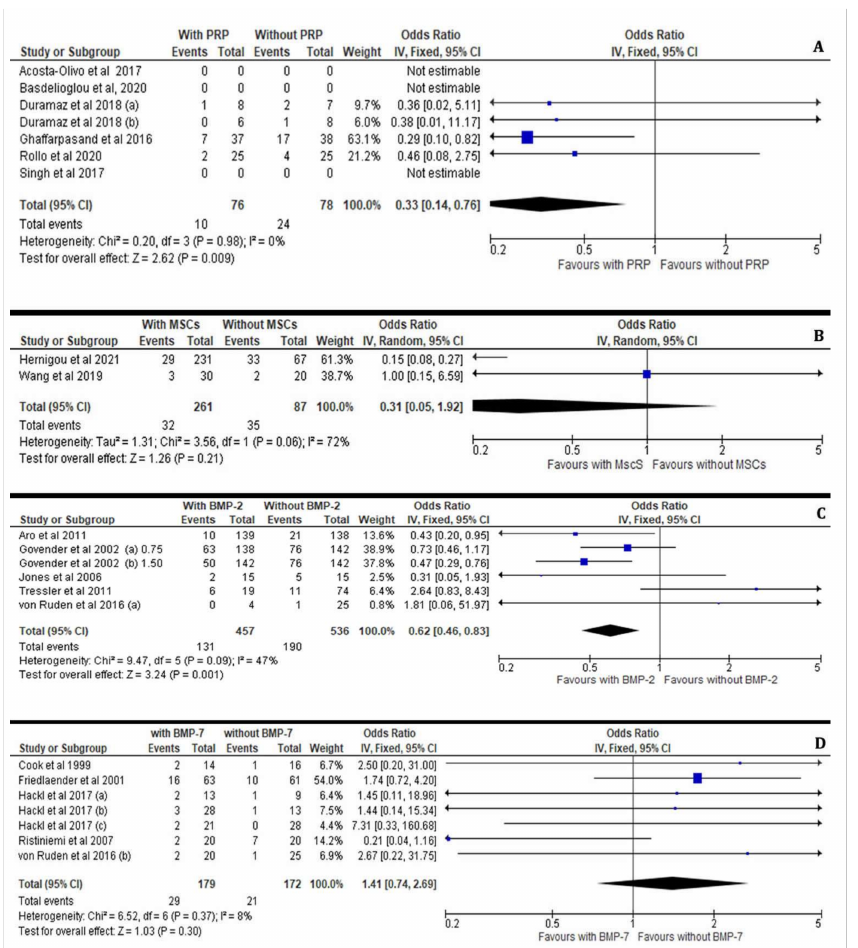
Figure 6. Forest plot displaying the efficacy of BMP-2 administration on open fractures of long bone diaphysis [21,27,32,35,36].